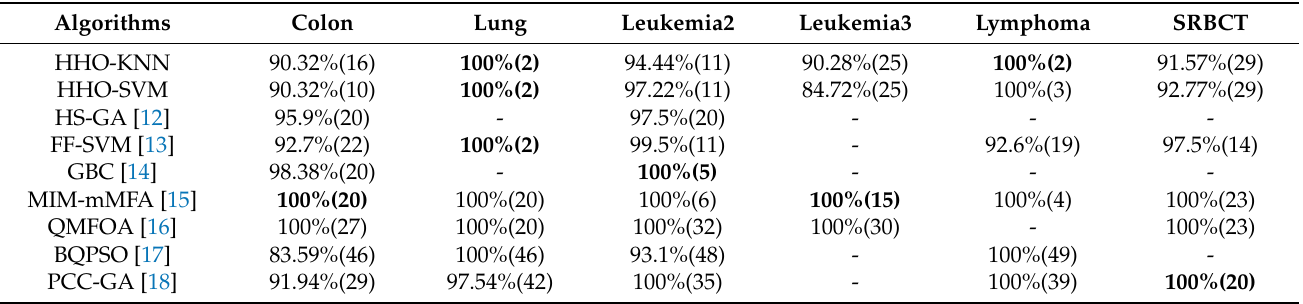
Table 9. Comparison between the proposed selection methods and previous methods in terms of the number of selected genes and